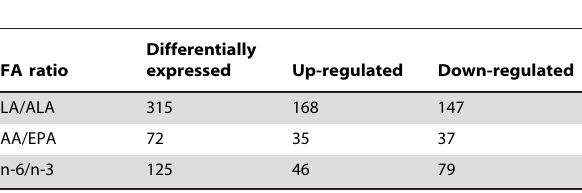
Table 3. Number of differentially expressed genes (t-tests, p #